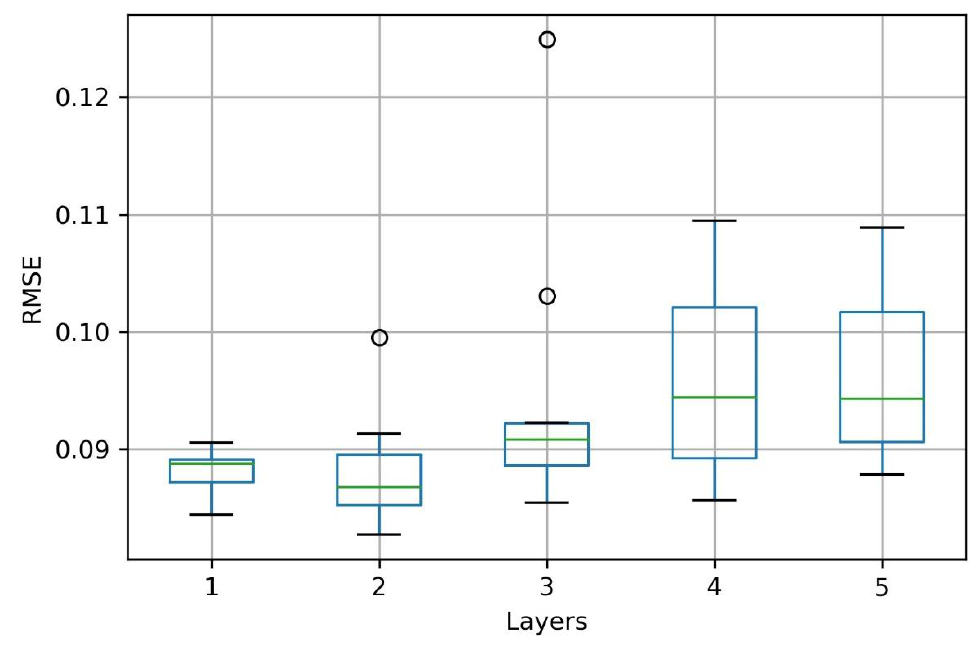
Figure 6. Box-and-whisker plot for layer number selection.